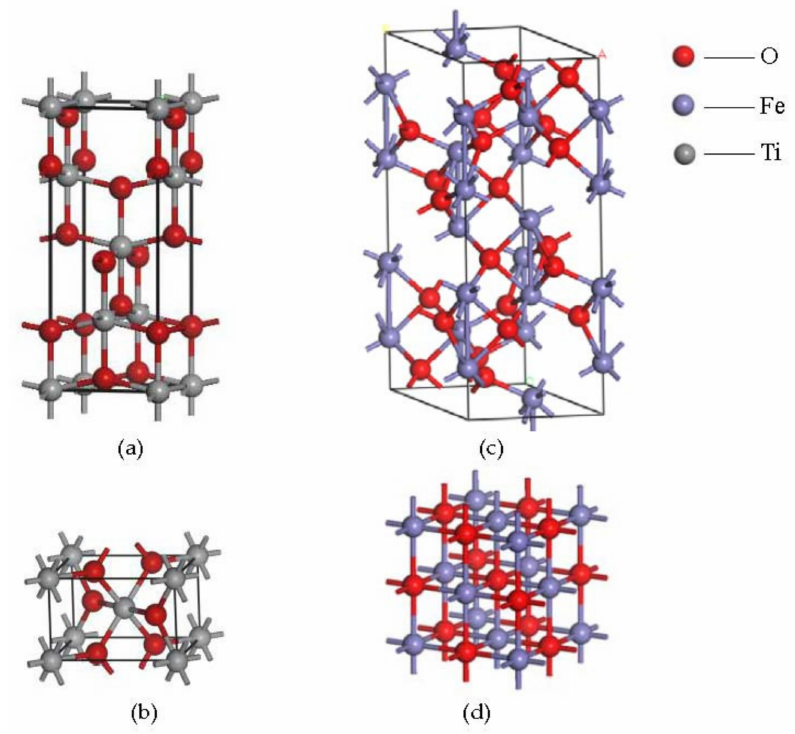
Figure 10. The crystal structures of ( a ) anatase nano-TiO 2 ( b ) rutile nano-TiO 2 ( c ) Fe 2 O 3 and ( d )